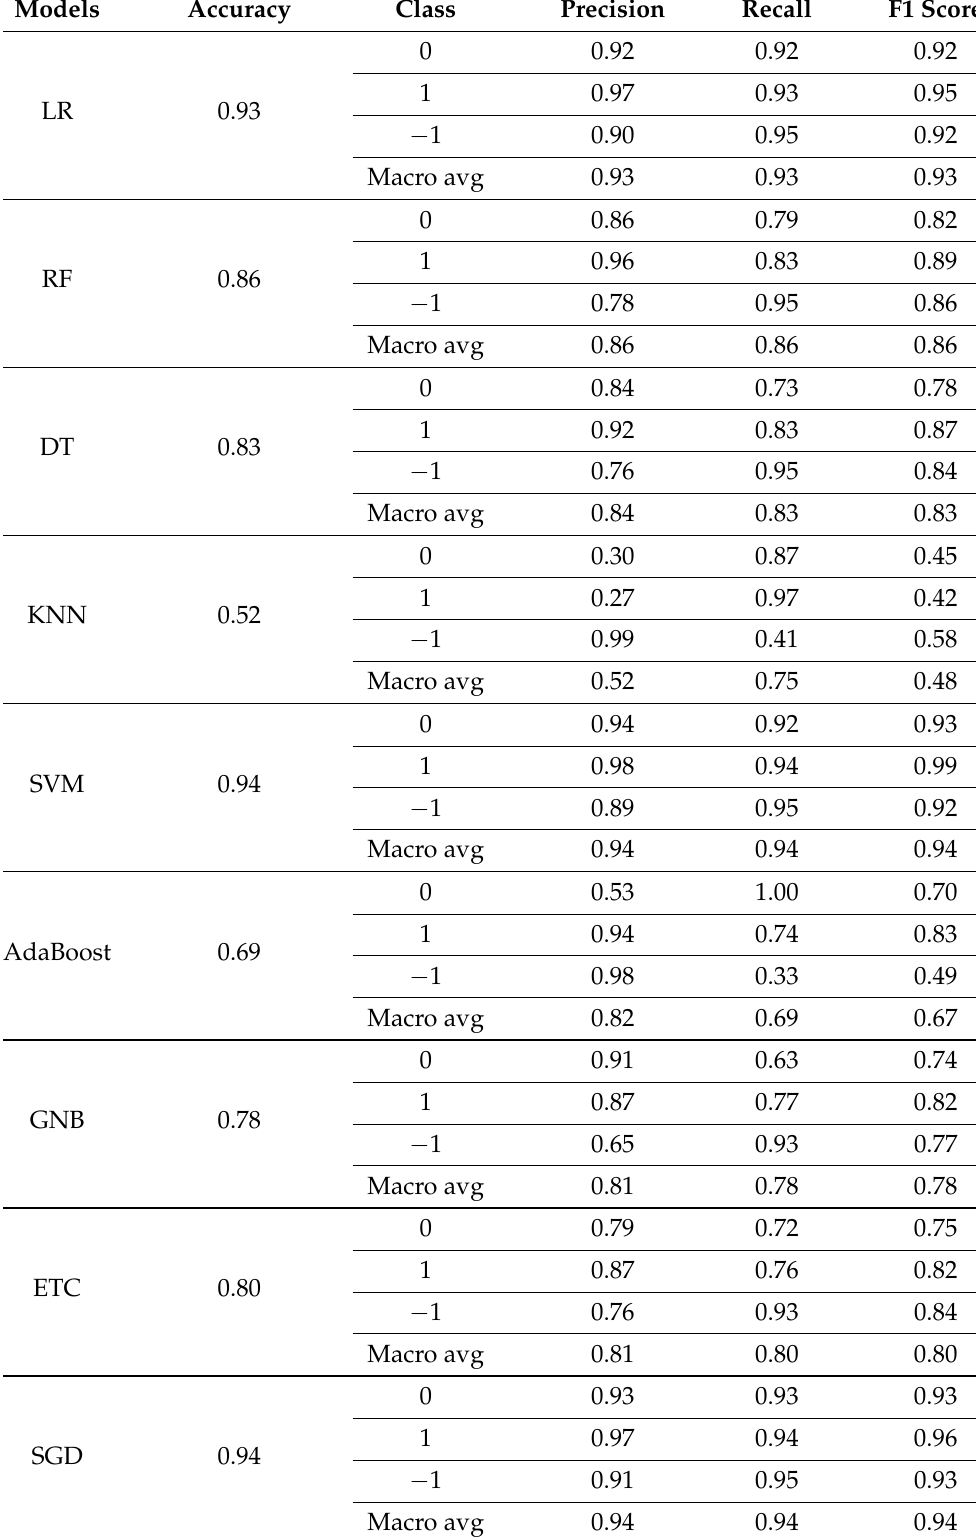
Table 10. Results using BoW features on the original